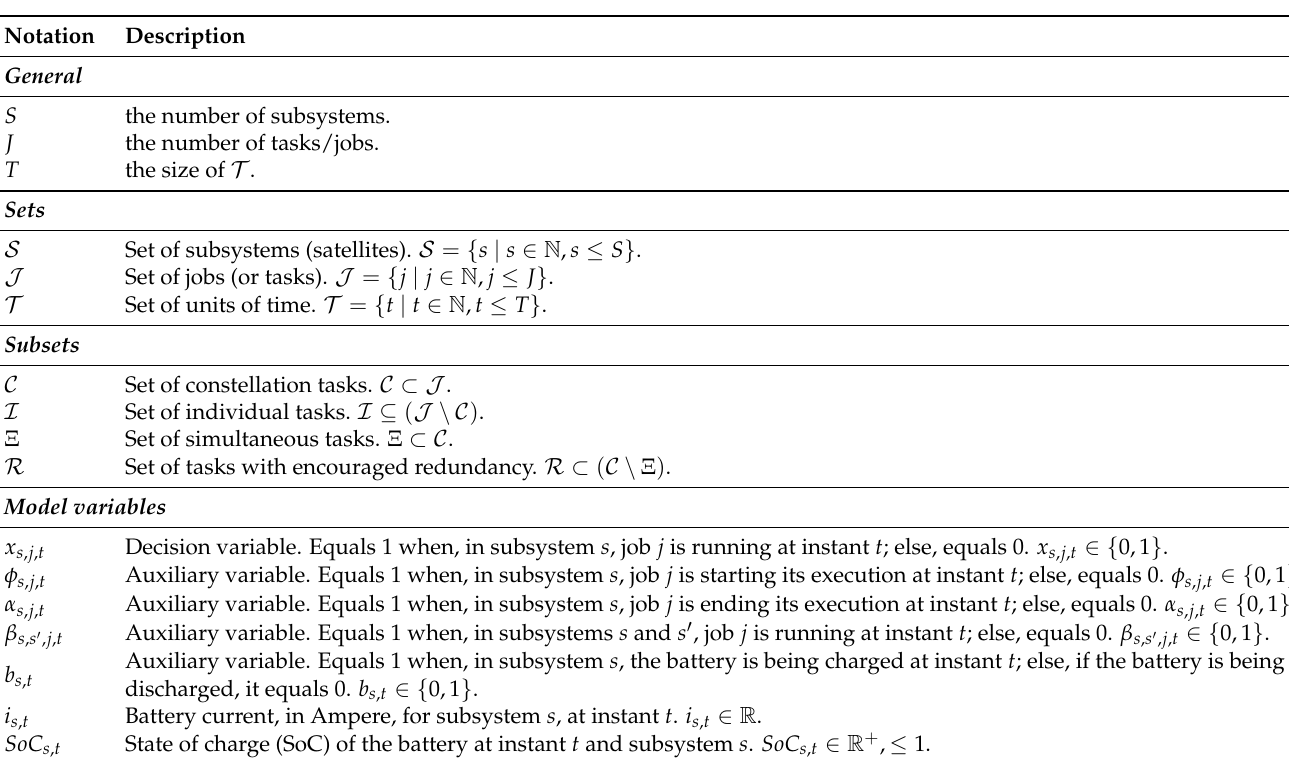
Table 1. Sets and model